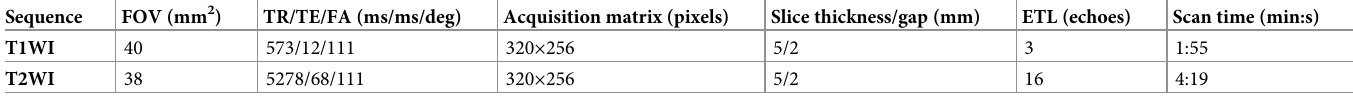
Table 1. Pelvic magnetic resonance image acquisition